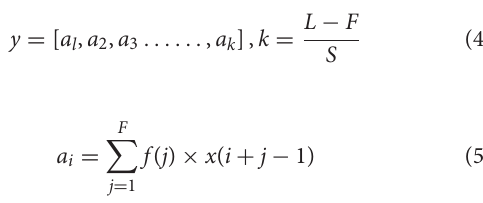
Frontiers in Cell and Developmental Biology |